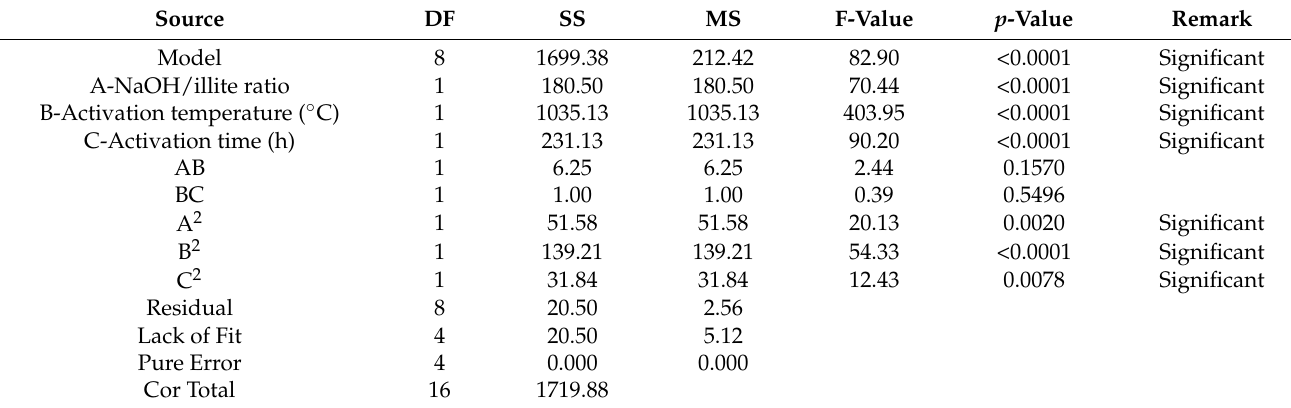
Three ‐ dimensional response surfaces plotted as a function of two input parameters